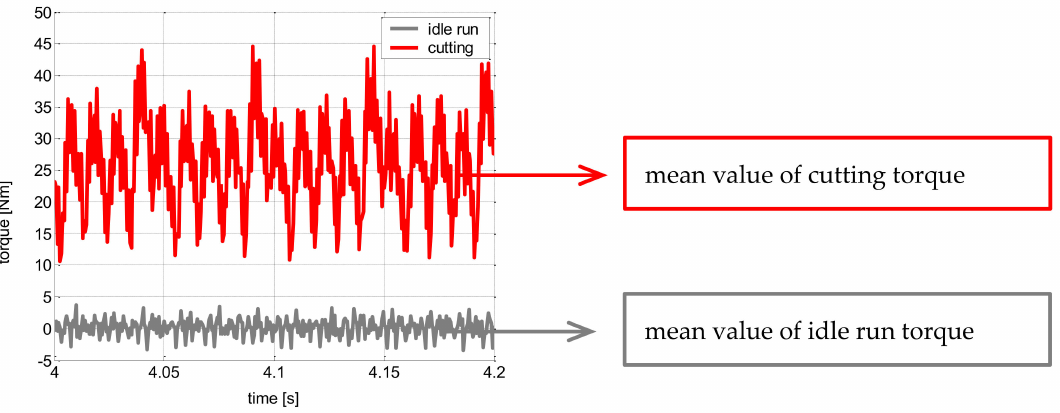
Figure 8. Example of measured torque time signals: MCU700, a p = 3 mm, and f z = 0.25